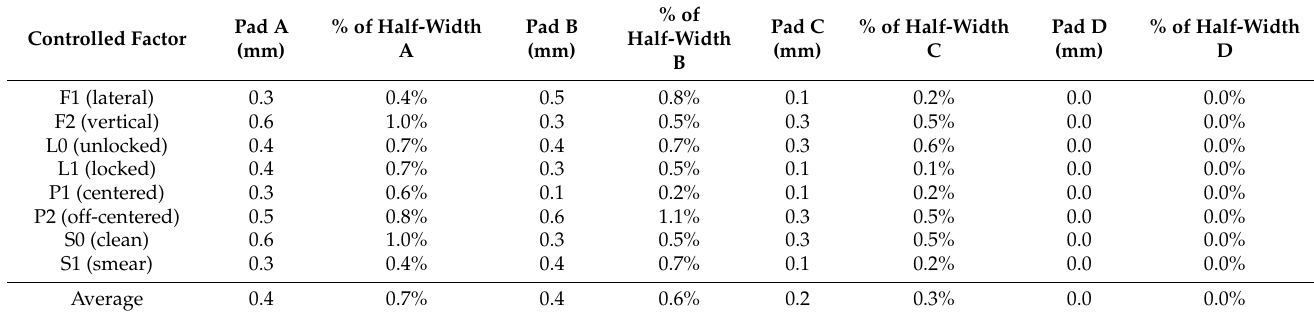
Table 6. Square support pad with rubber cover (Pa1)—Mean support pad slippage for different controlled factors.